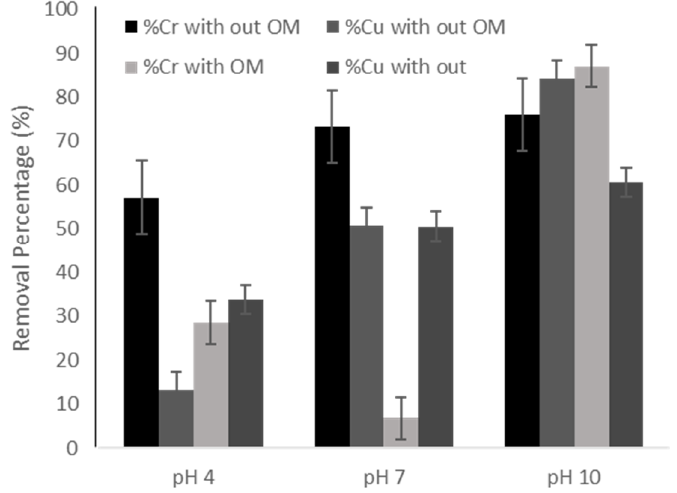
Figure 5. Removal percentages of the metals copper and chrome in the presence and absence of organic material.